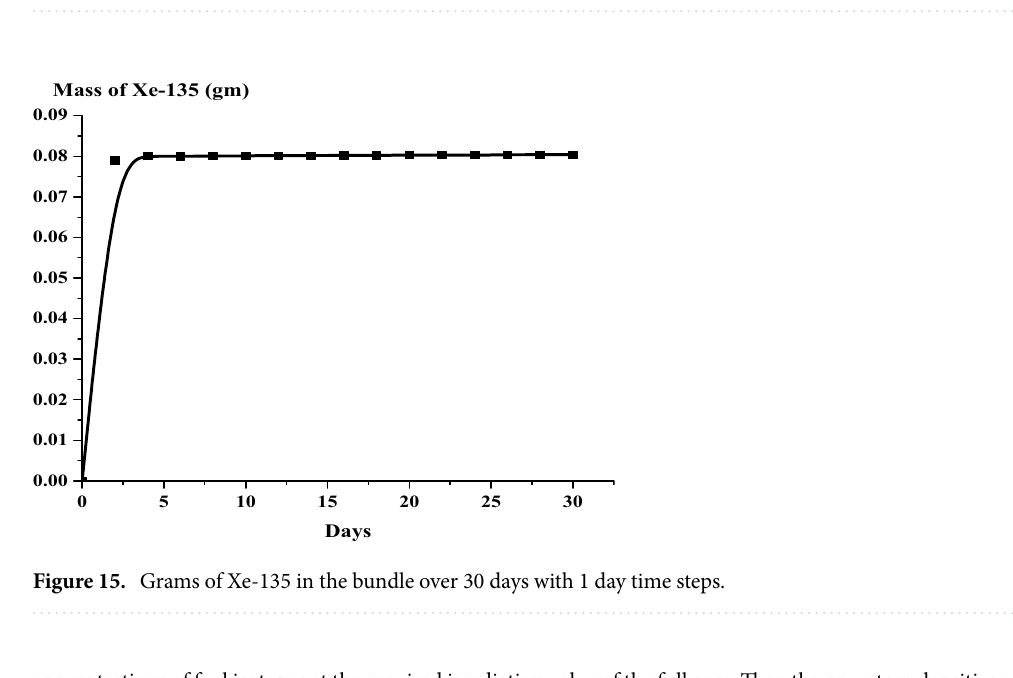
Figure 14. K-effective results for 30 day burn with 1 day time steps.